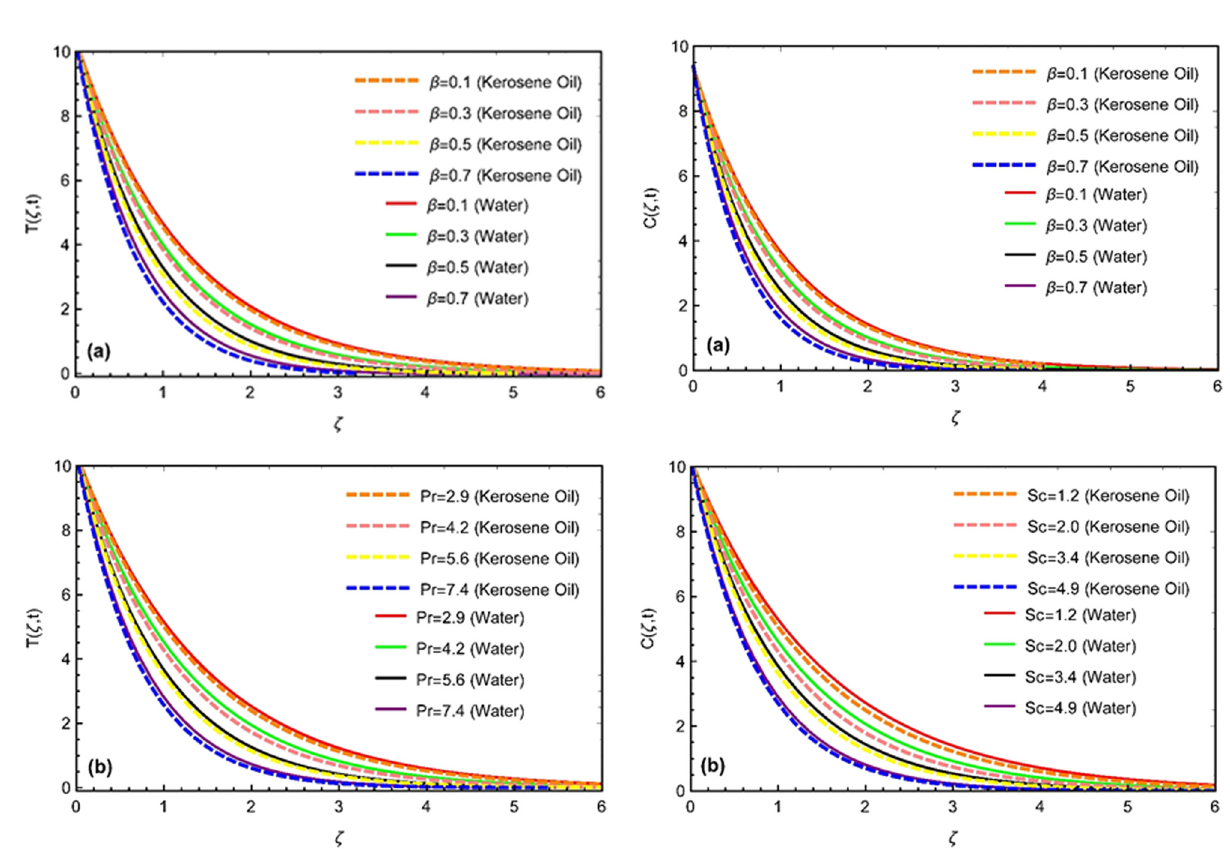
Figure 3: ( a and b ) E ff ects of β , Sc on concentration pro fi le. Figure 2: ( a and b ) E ff ects of β , Pr for temperature pro fi